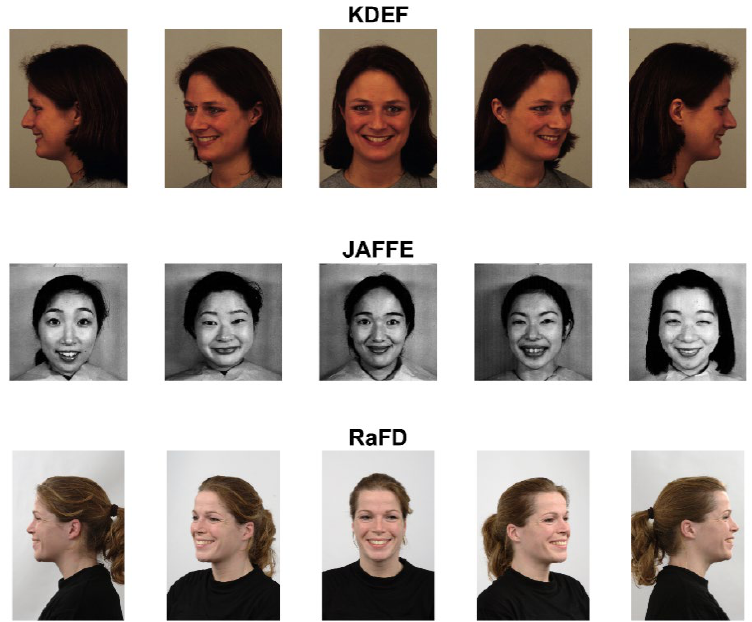
Figure 1. Sample images from the three databases represent the emotion of happiness. Databases KDEF (https://www.kdef.se/, accessed on 16 February 2022) and RaFD (https://rafd.socsci.ru.nl/ RaFD2/RaFD?p=main, accessed on 25 February 2022) have five poses, while JAFFE (https://zenodo. org/record/3451524#.YvCEcehBxPY, accessed on 16 February 2022) has only one (frontal)